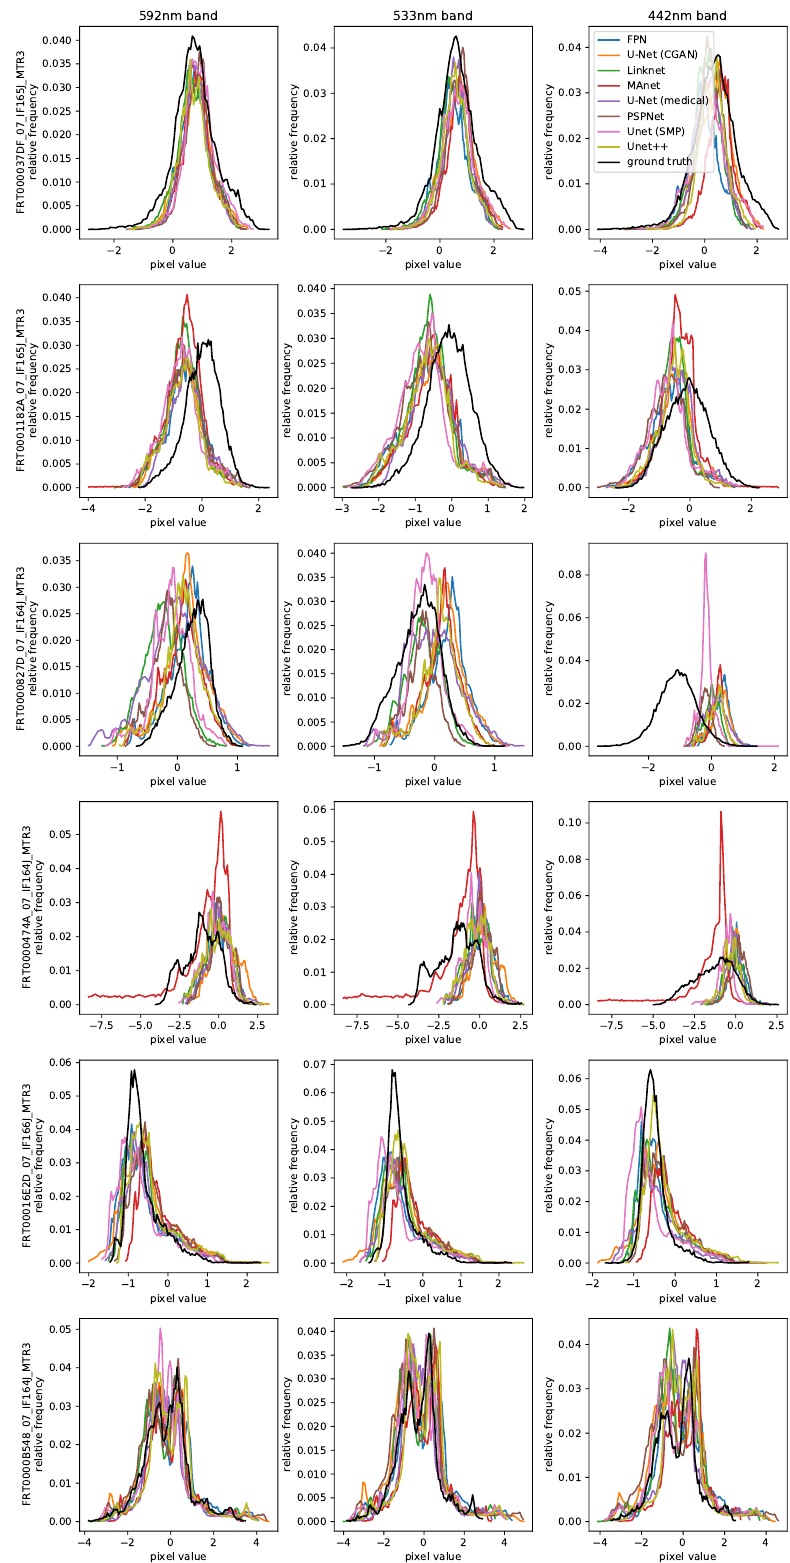
Figure 8. Channel-wise histogram comparison of six EVC test patches across different model archi- tectures. Rows correspond to the respective rows in Figure